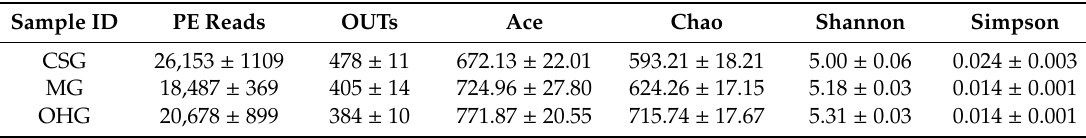
Table 7. PE reads and alpha diversity of sheep rumen fluid bacterial community at di ff erent groups. Sample